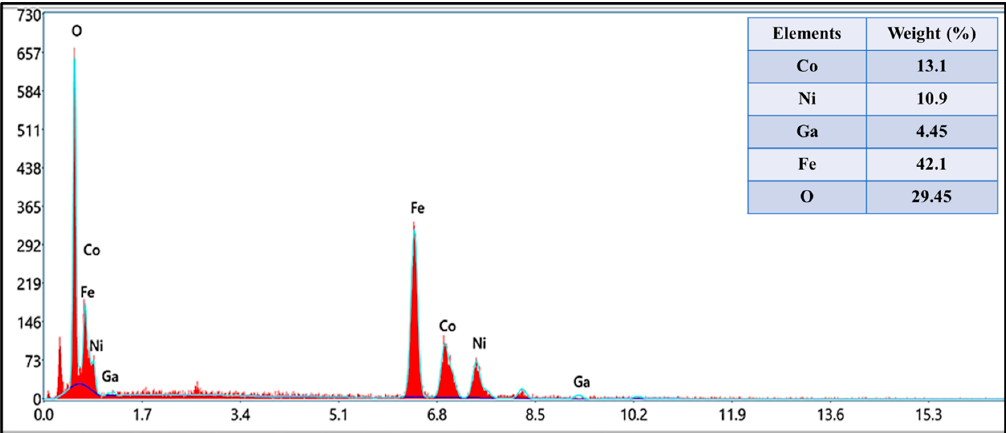
Figure 3. EDX of Co 0.5 Ni 0.5 Ga x Fe 2-x O 4 (x = 0.2) MCs.